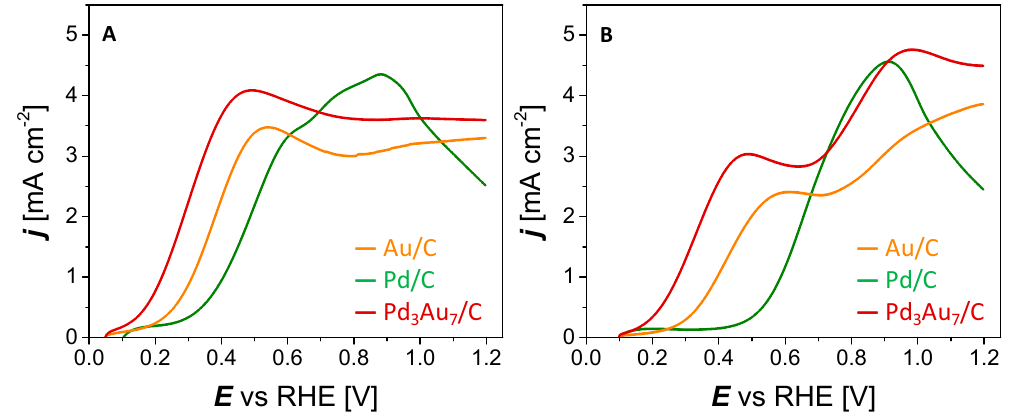
Figure 4. Third stable linear scan voltammetry curves recorded in a 0.10 mol L − 1 NaOH aqueous electrolyte at 5 mV s − 1 on Pd / C (green), Au / C (orange) and Pd 3 Au 7 / C (red) catalysts in the presence of ( A ) 0.10 mol L − 1 glucose and ( B ) 0.10 mol L − 1 xylose.